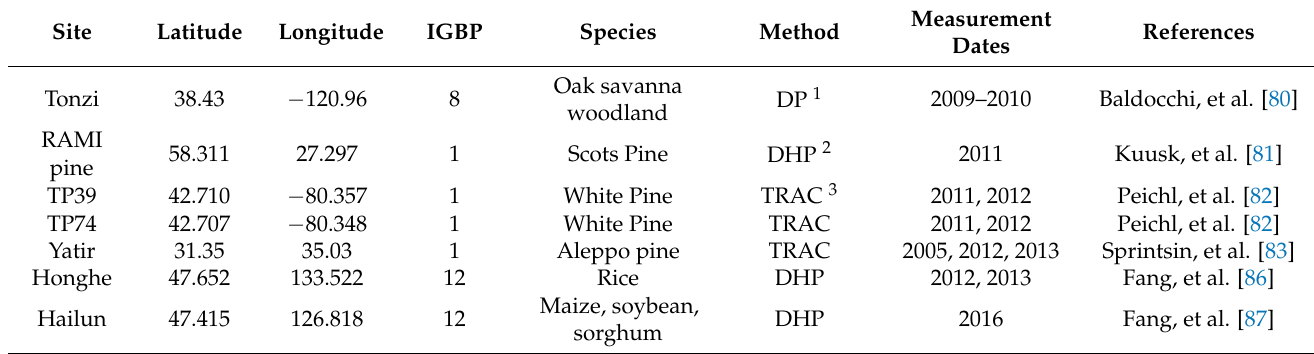
Table 2. Characteristics of validation sites with seasonal profiles of field-measured CIs.